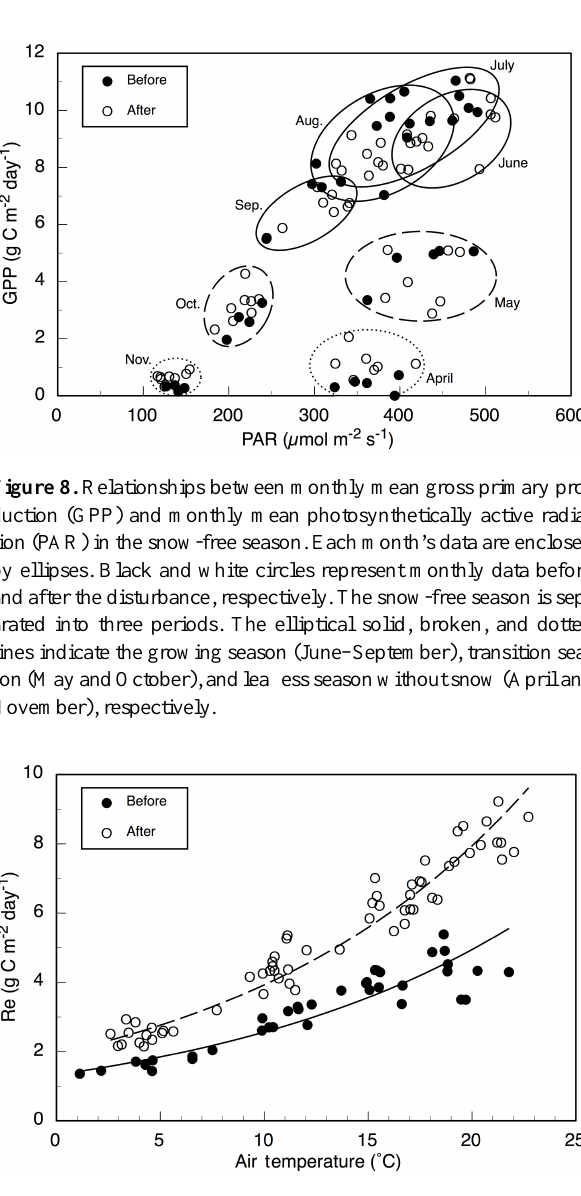
Figure 9. Relationships between monthly mean ecosystem respira- tion (Re) and mean air temperature (Ta) in the snow-free season. Black and white circles represent values before and after the dis- turbance, respectively. The solid line indicates the regression equa- tion before the disturbance, i.e., Re = 1 . 94 × 2 . 02 Ta / 10 . The bro- ken line indicates the regression equation after the disturbance, i.e., Re = 1 . 33 × 1 . 93 Ta / 10 .